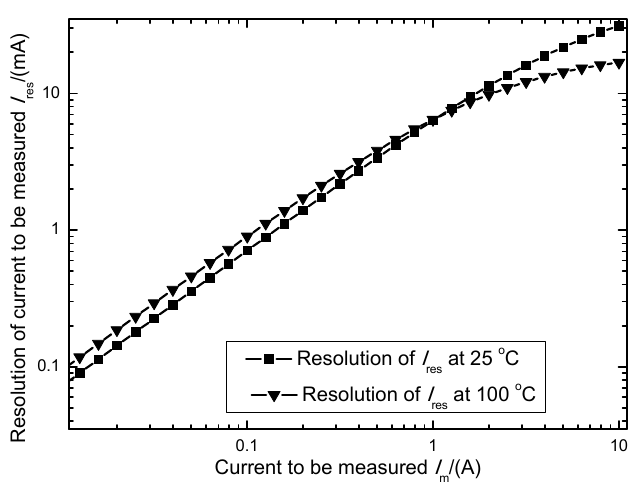
Figure 8. Diagram showing relation between resolution I res and current to be measured I m.